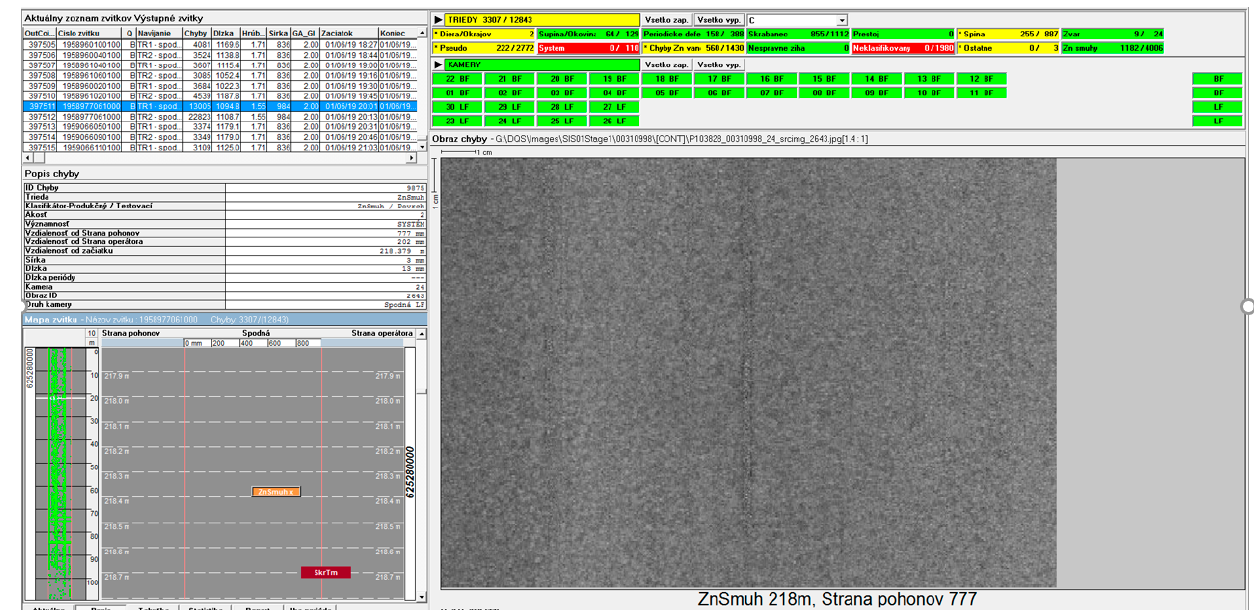
Figure 11. Scratch 5897706 — identified after zinc-coated sheet metal.